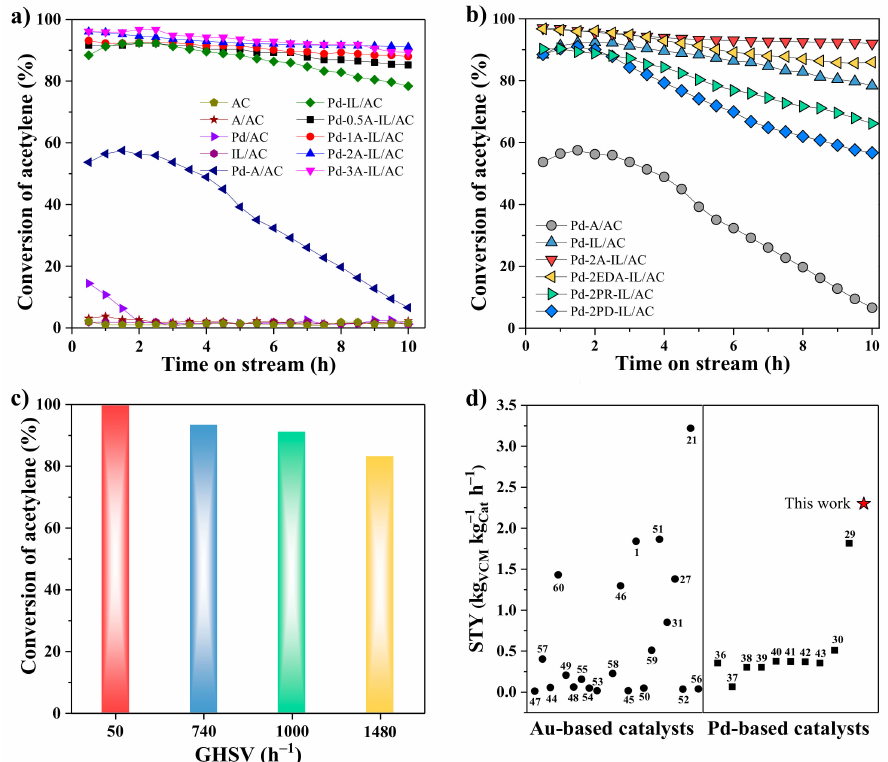
Figure 1. ( a , b ) Conversion of acetylene over di ff erent catalysts. Reaction conditions: T = 160 ◦ C, GHSV = 1000 h − 1 , and V / V = 1.2. ( c ) Catalytic performance of Pd-2A-IL / AC catalyst at di ff HCl C2H2